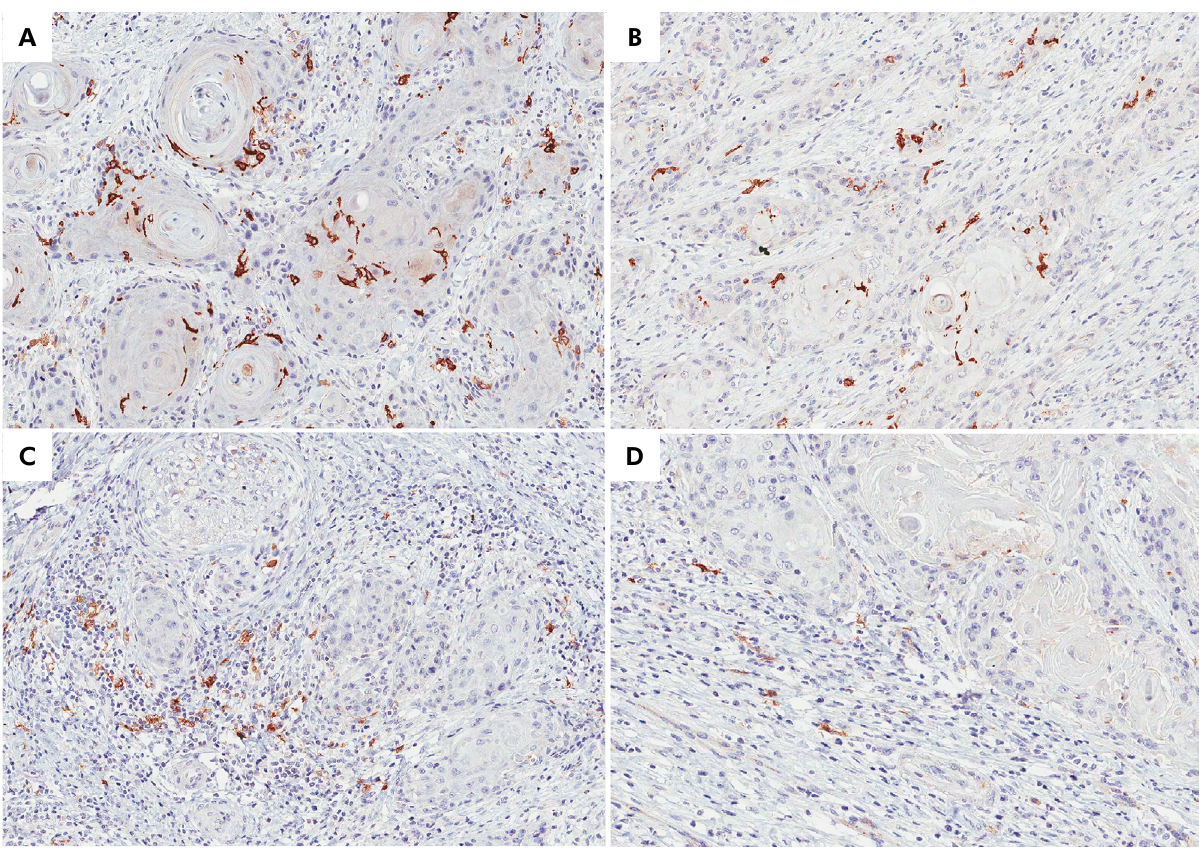
Figure. Immunohistochemical expression of CD1a+ and CD83+ cells in the tongue of non-smokers and smokers with oral squamous cell carcinoma. CD1a+ cells in non-smokers and smokers (A and B respectively). CD83+ cells in non-smokers and smokers (C and D respectively). High magnification